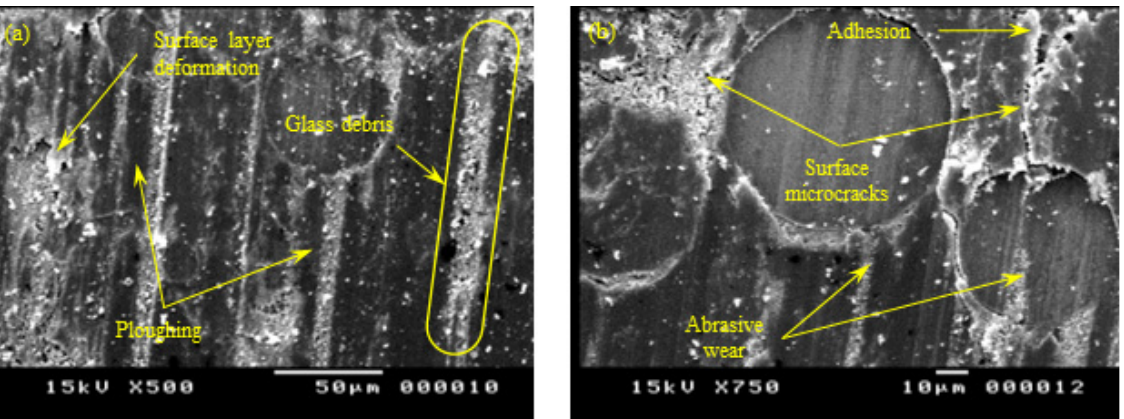
Figure 14. SEM of the tribo-surface for the YZ-plane specimen (50 N, 0.25 m/s, and 45 min) at 500× ( a ) and 750× ( b ) magnification.